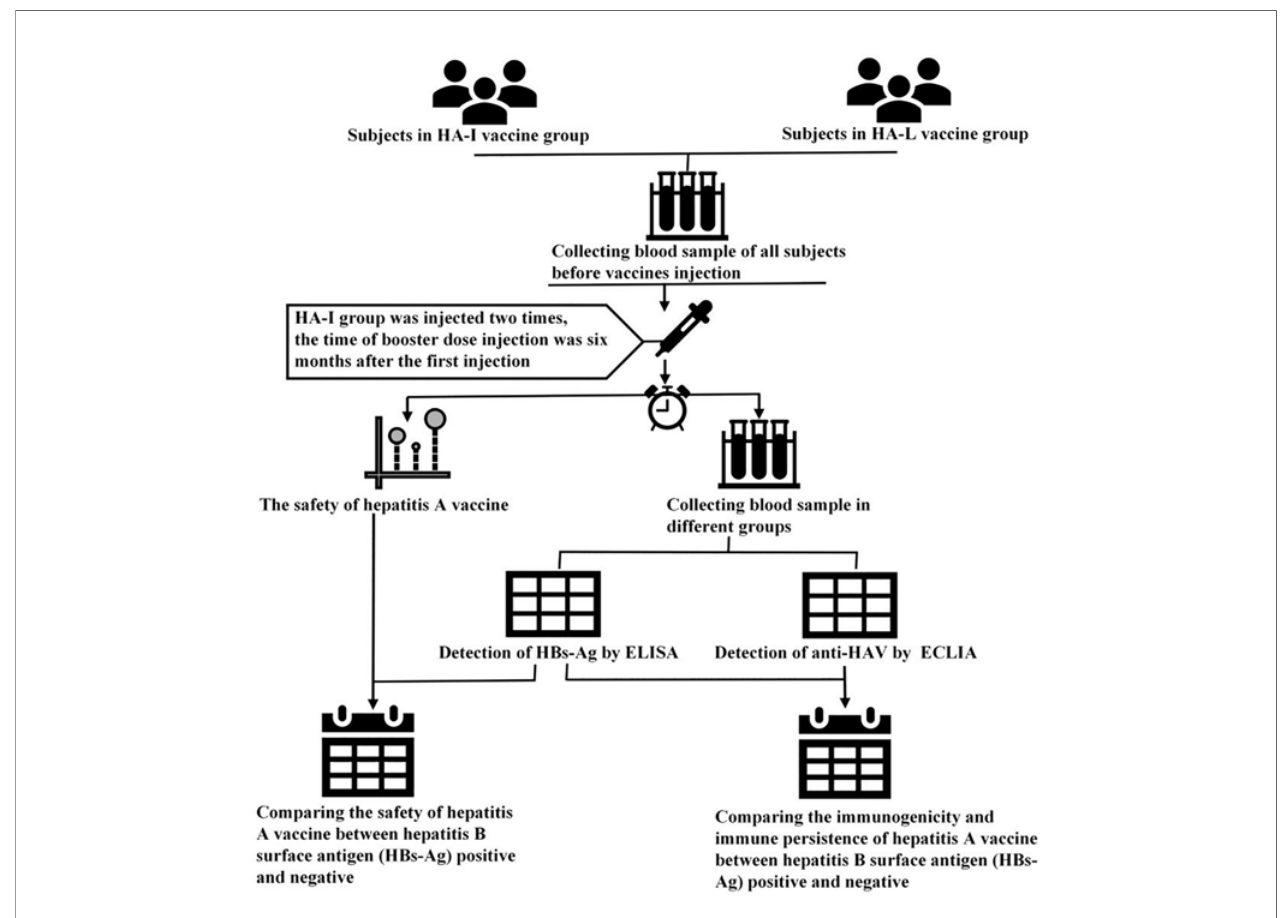
FIGURE 1 | The research strategy of this